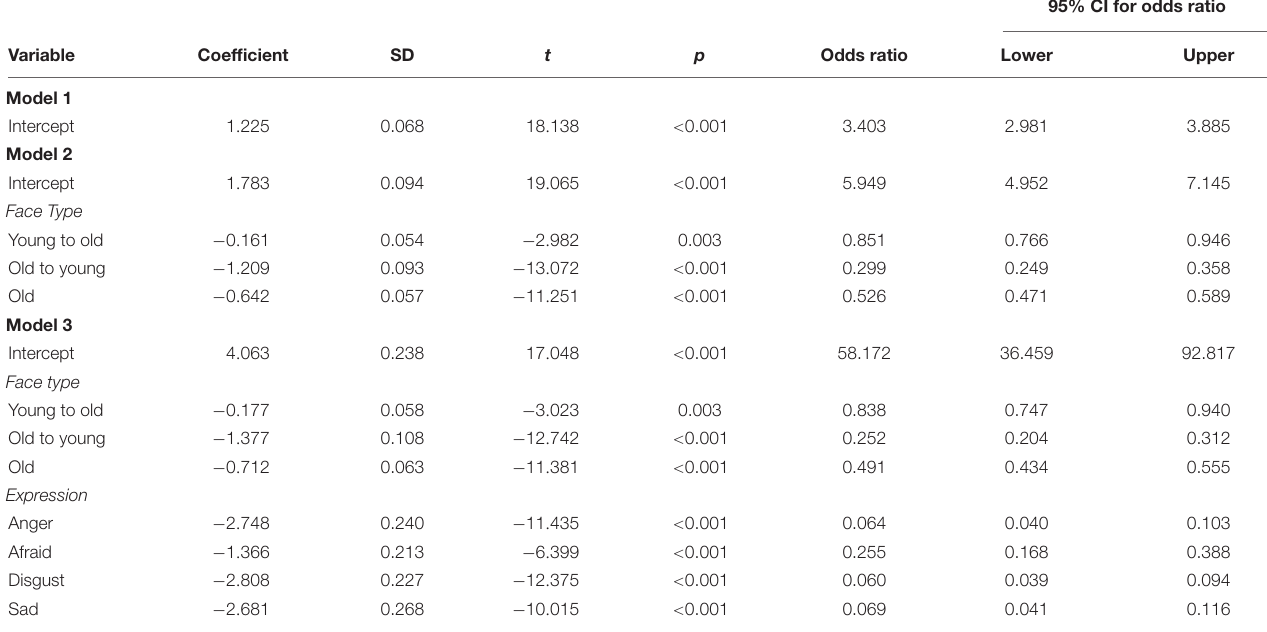
TABLE 1 | Results of logistic regression for accurate identifications of facial